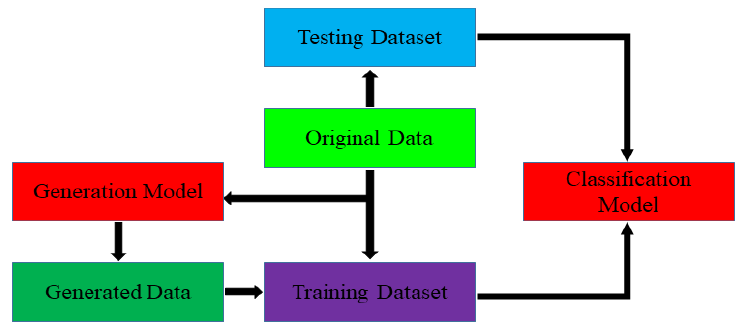
Figure 10. The workflow of the image generation based on Adversarial-VAE networks.